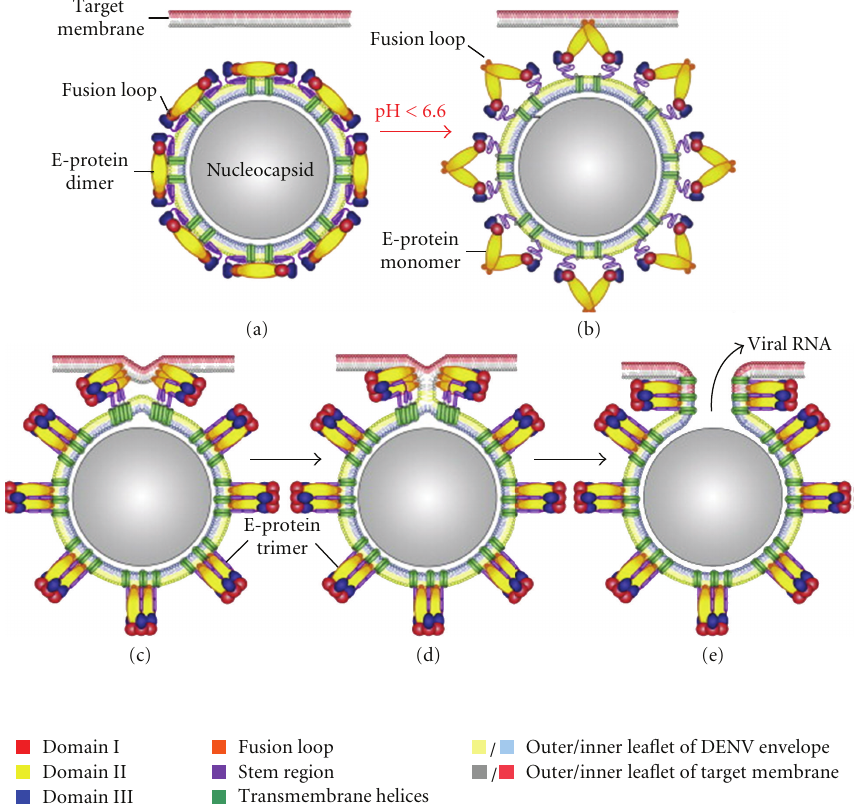
Figure 1: Schematic overview of the DENV membrane fusion process (modified figure from Stiasny et al., Amino Acids, 2009 [25]). (a) Prefusion conformation of the E-protein consists of homodimers on the virus surface. (b) Low endosomal pH triggers dissociation of the E- dimers into monomers which leads to the insertion of the fusion peptide with the endosomal target membrane. (c) A stable E-protein trimer is folded in a hairpin-like structure. (d) Hemifusion intermediate in which only the outer leaflets of viral and target cellular membranes have fused. (e) Formation of the postfusion E-trimer and opening of the fusion pore allow the release of the viral RNA into the